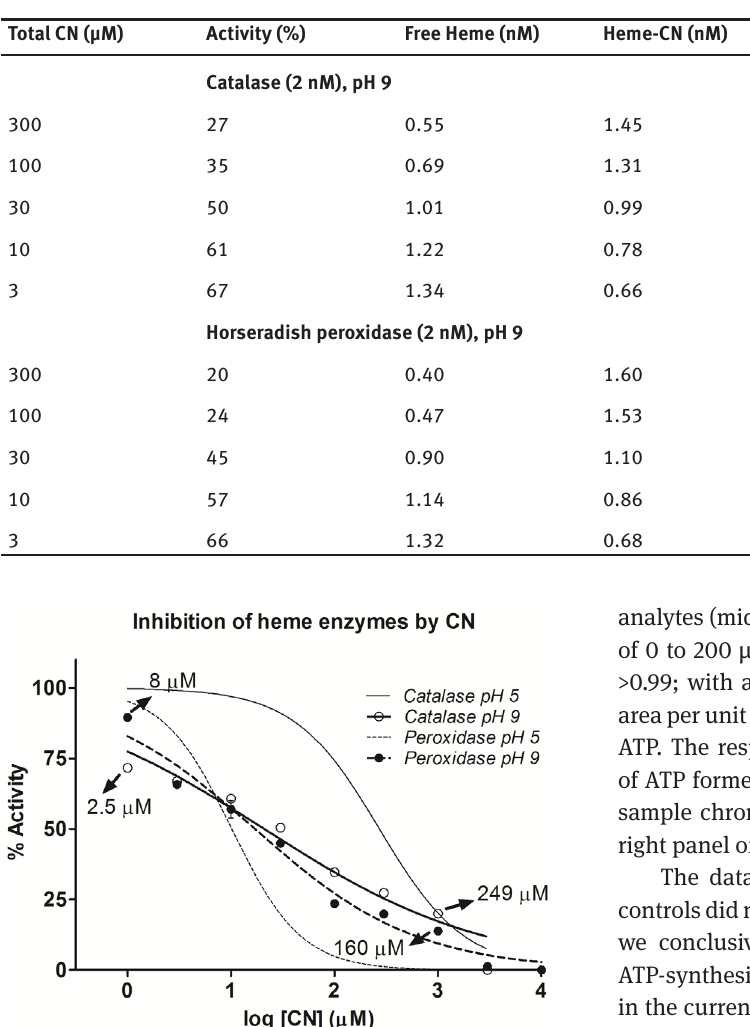
(extrapolation from experimental inhibition values) for data points of Figure 1 (pH 9) (excluding the Table 6: Determination of functional K d ones already mentioned in Figure 1). It is evident that the K values calculated from reaction kinetics increase upon increasing the ligand d concentration, which is something that does not stand by the basic premises of the binding-based